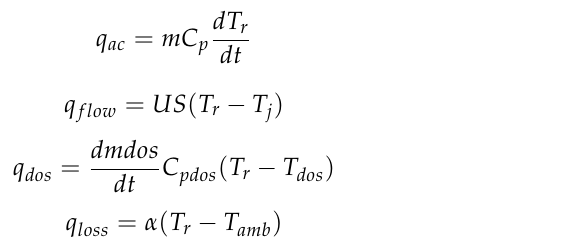
Figure 10. Experimental results of the control experiment without the microPCMs.